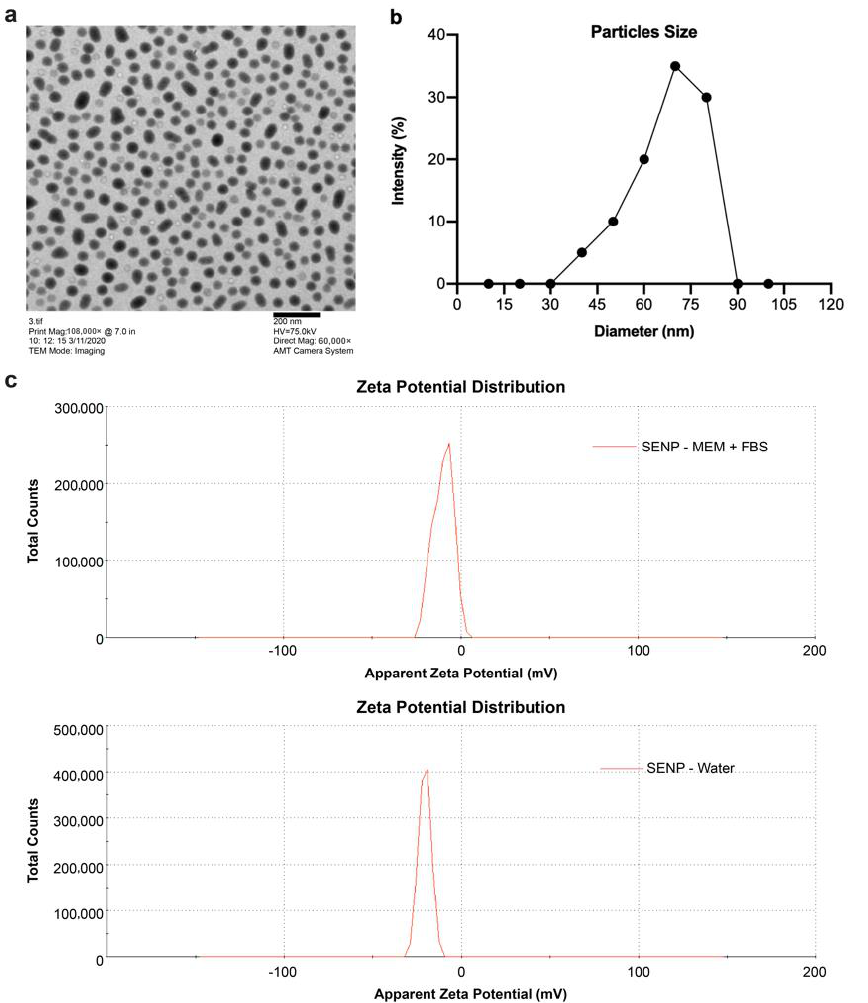
Figure 1. ( a ) Transmission electron microscopy (TEM) scan (scale bar: 200 nm) of selenium nanopar- ticles (SeNPs) at a magnification of 60,000 × g and voltage of 75.0 kV. Nanoparticles were mostly segregated from one another and were nearly spherical. ( b ) Nanoparticle average size distribution. ( c ) Zeta potential of SeNPs at 25 °C.